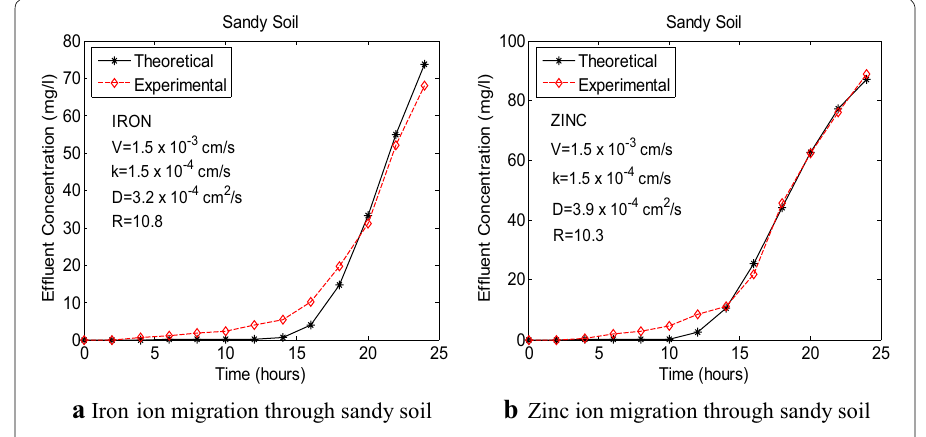
Fig. 6 Migration of ions through sandy soil